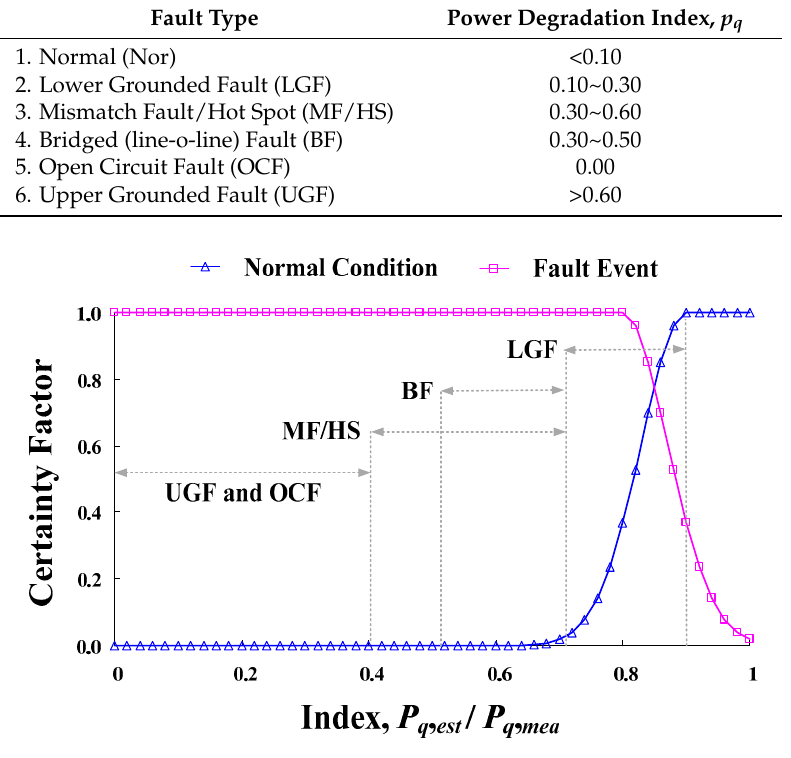
Figure 3. The certainty factors versus the index, p q , for normal condition and fault types.